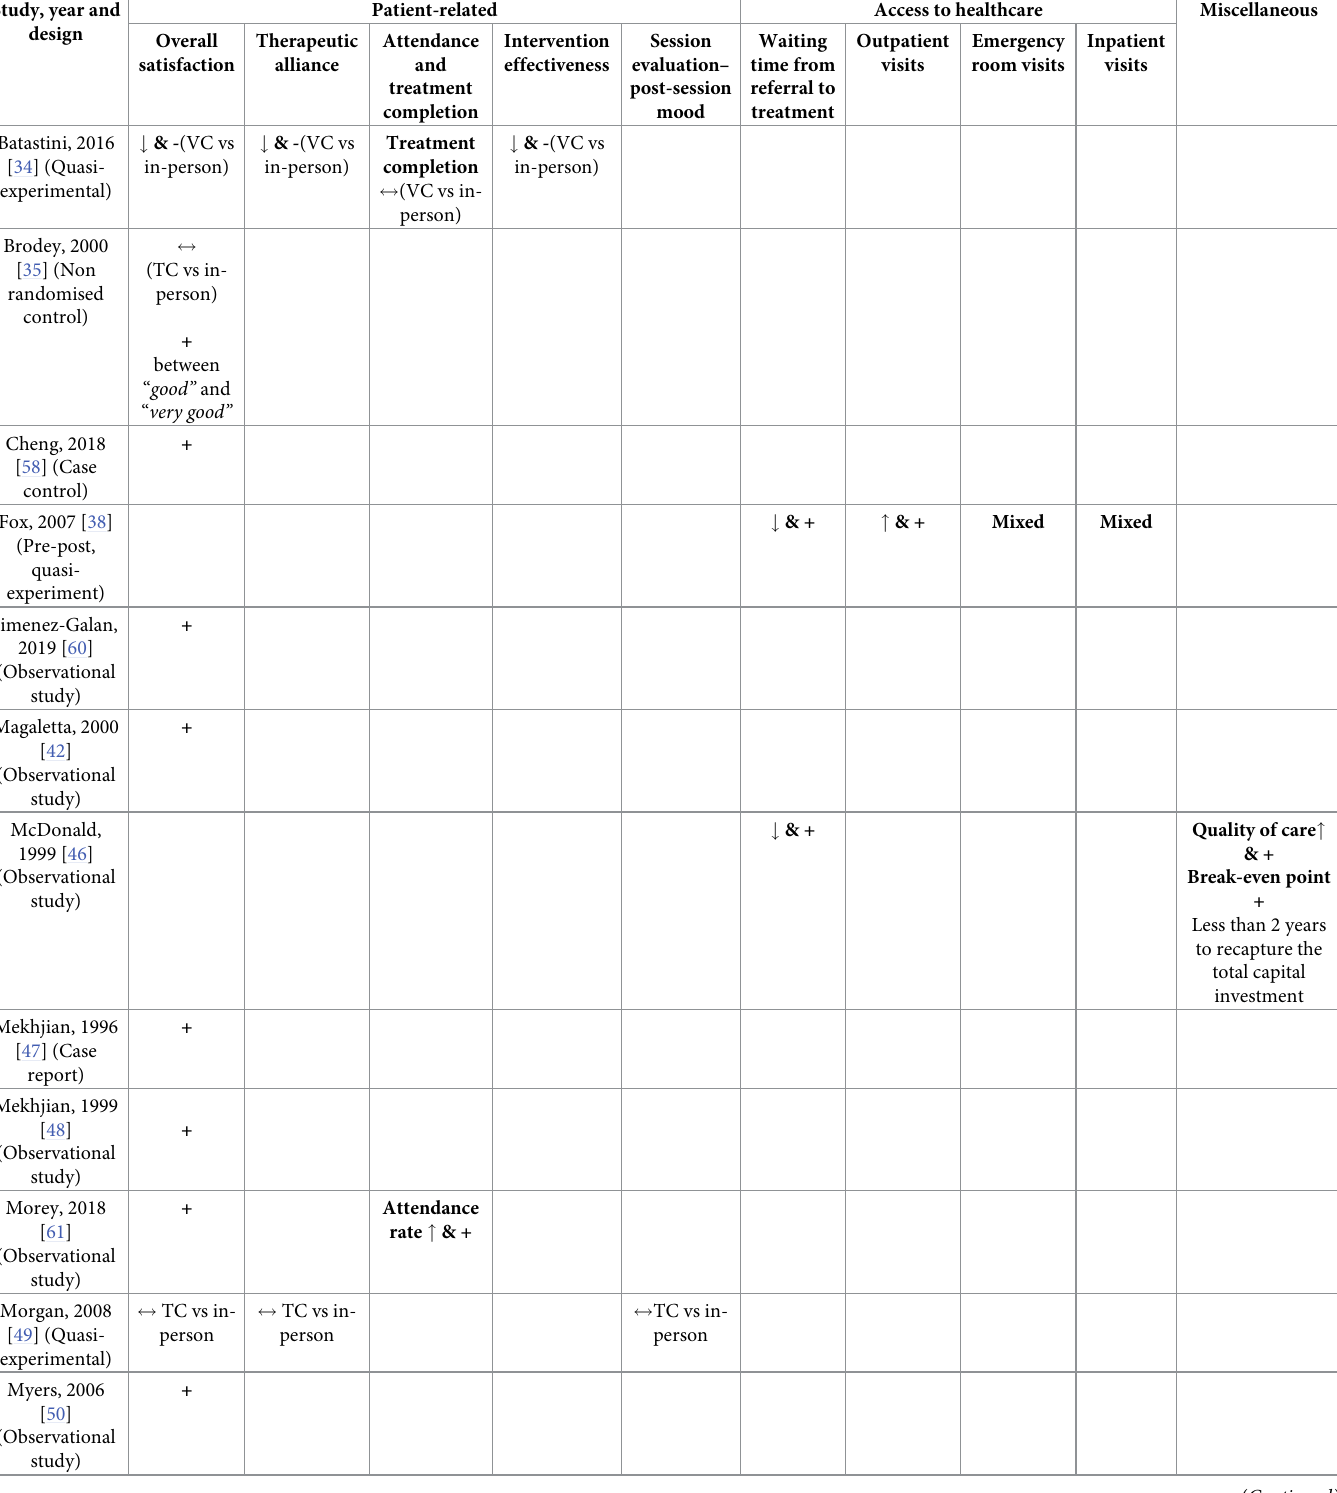
Table 3. Process-related